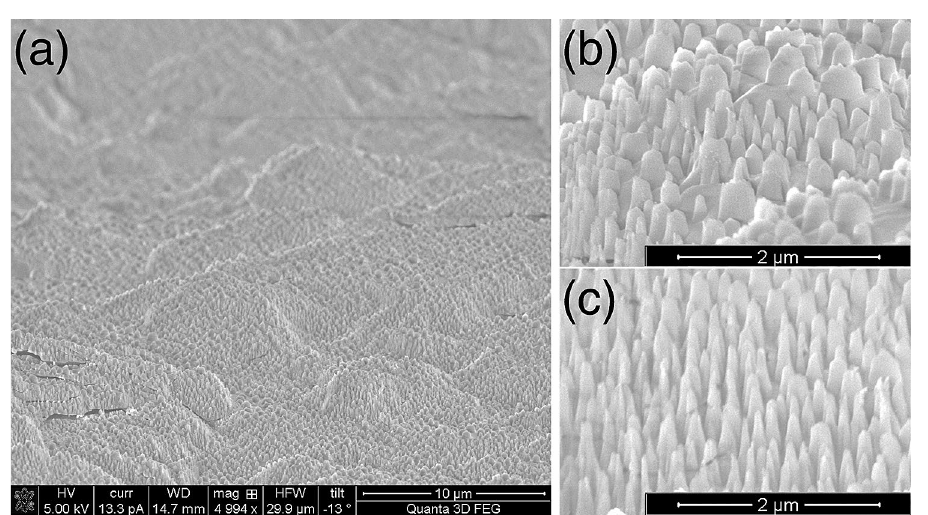
Figure 4. NPhC created on the unpolished side of the SSP sapphire substrate ( a ). Subfigure ( b ) shows larger NPhC which tend to form on hilltops; ( c ) the smaller NPhC form mostly on